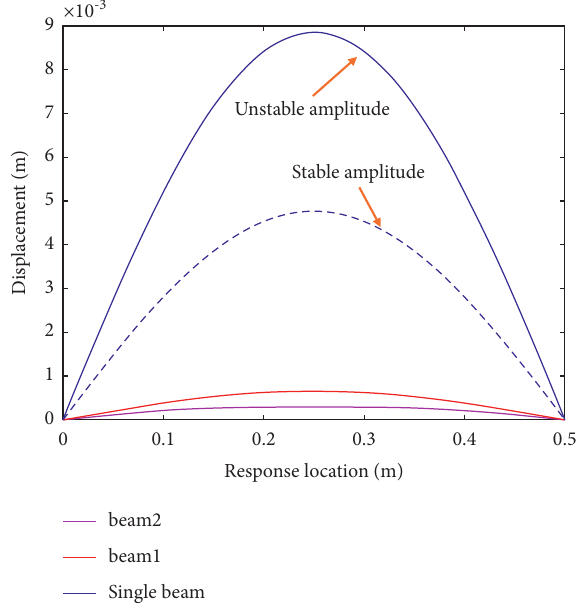
Figure 24: Comparison of vibration response amplitude.